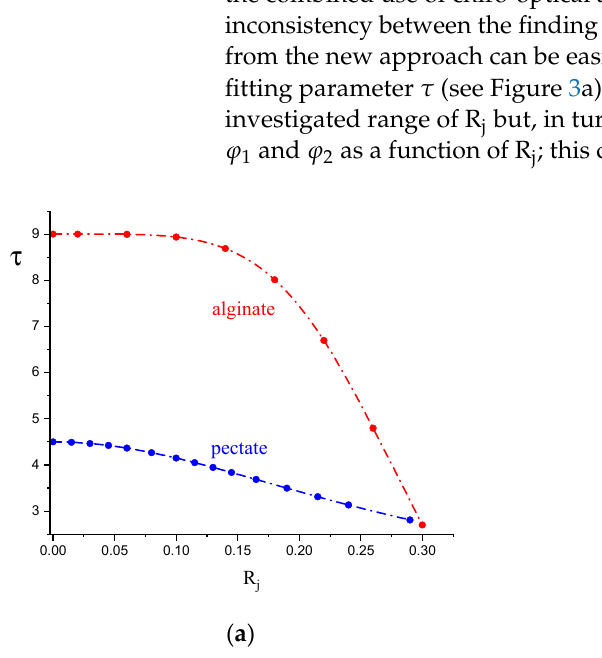
Figure 3. Dependence on the calcium-to-polymer molar ratio Rj of the parameter τ ( a ), and of the parameters ϕ 1 and ϕ 2 ( b ) for alginate (upper, red curve in ( a )) and pectate (lower, blue curve in ( a )). The colors of the polymer labels (text and frame) in panel ( b ) correspond the relative curves, respectively. The values have been determined according to the procedure (and using the numerical values of the parameters) reported in the Appendix A.